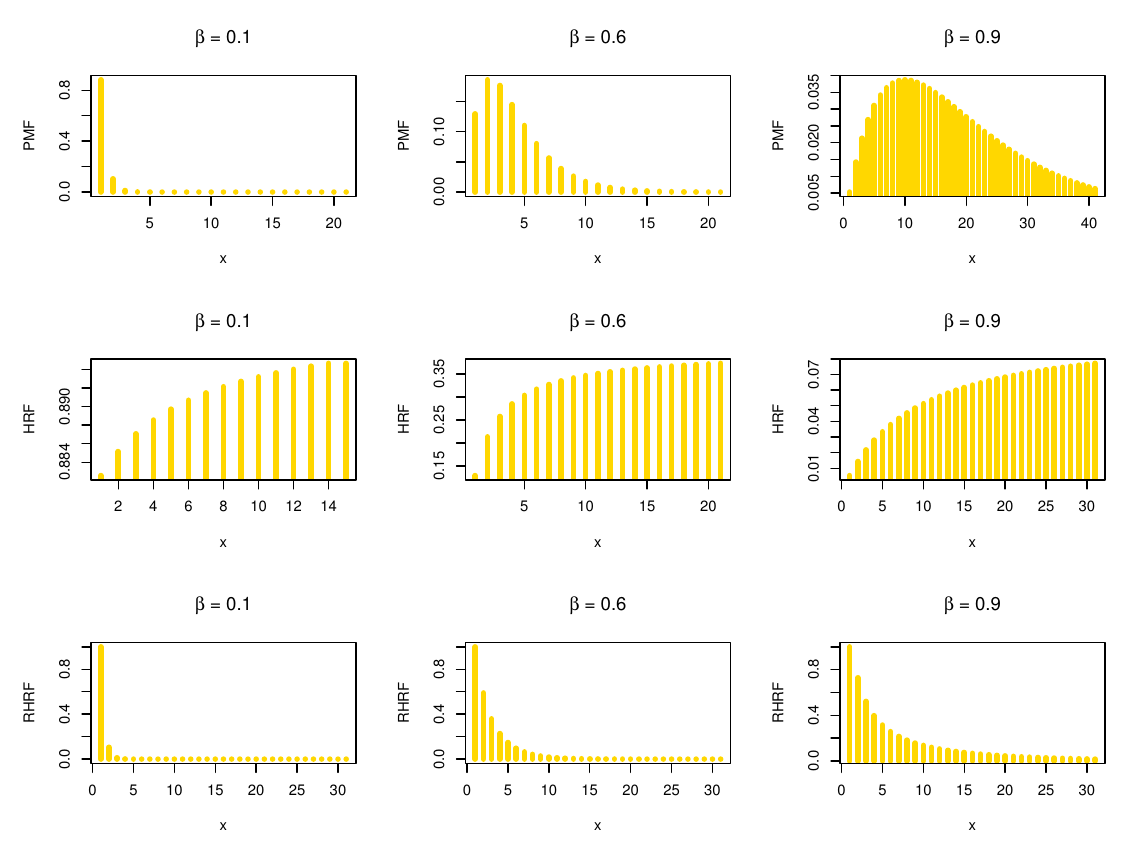
Figure 1. The PMF, HRF and RHRF plots of the NDsLE model. Based on Figure 1, it is noted that the f β ( x ) of the NDsLE model is unimodal, and it can be used as a probability tool to model asymmetric data. Moreover, the NDsLE model is a proper approach for modeling some phenomena which have increasing HRF or decreasing RHRF. Suppose Y and Z are two independent NDsLE RVs with parameters β 1 and β 2 , respectively. Then, the HRF of T = min ( Y , Z ) can be formulated